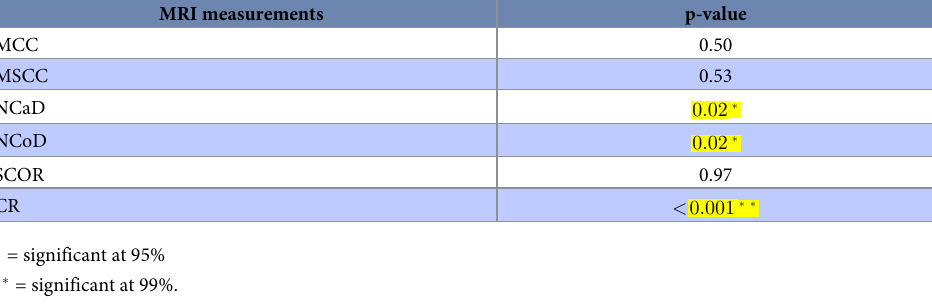
Table 4. The relationships between MRI measurements and the decision to